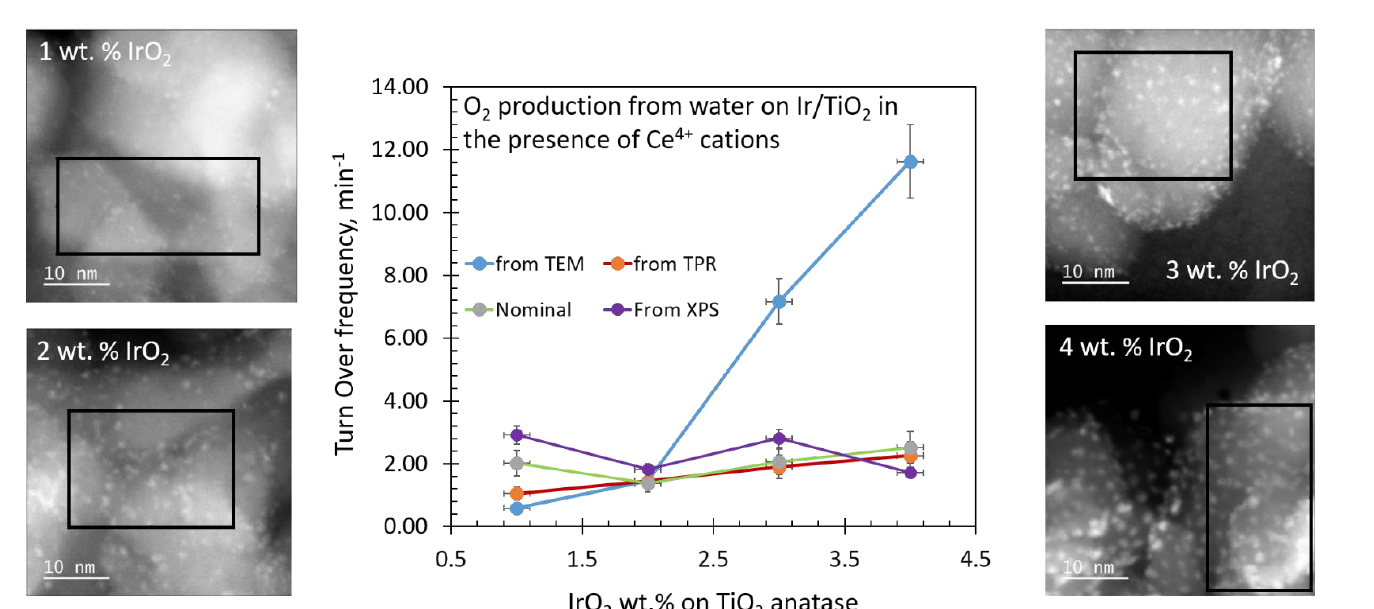
Figure 12. TOF using IrO 2 -TiO 2 catalysts with 1, 2, 3, and 4 wt.%. TON was obtained by dividing the reaction rates at t 1/2 by the number of Ir atoms in the catalyst, as determined from the used amount of Ir in preparing the catalysts (nominal), from the total amount of hydrogen used to reduce IrO 2 to Ir (TPR), from the amount of Ir atoms determined from the elemental composition by XPS, and the number of surface atoms of Ir in IrO 2 clusters from TPR, assuming a spherical model, as described in the experimental section. The rectangles in the STEM images show the areas used to count the number of clusters in the four catalysts, from which their surfaces were extracted, assuming a hemispherical shape; deviations from these numbers were found to be negligible. The counting, within a few %, did not change from one area to the other of the same catalyst. The error bars are based on observed experimental deviations.